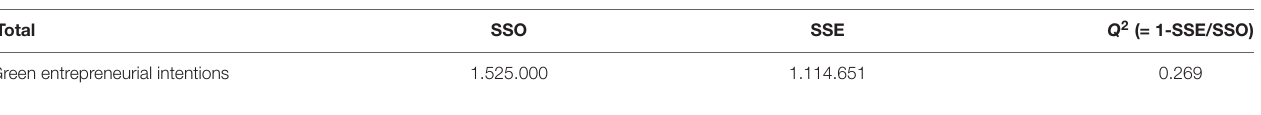
TABLE 6 | Predictive relevance (blindfolding